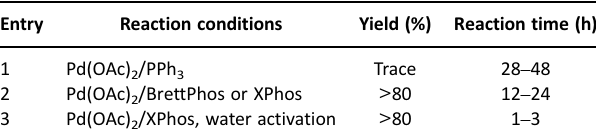
Table 1 . Optimization of reaction conditions for the amination of